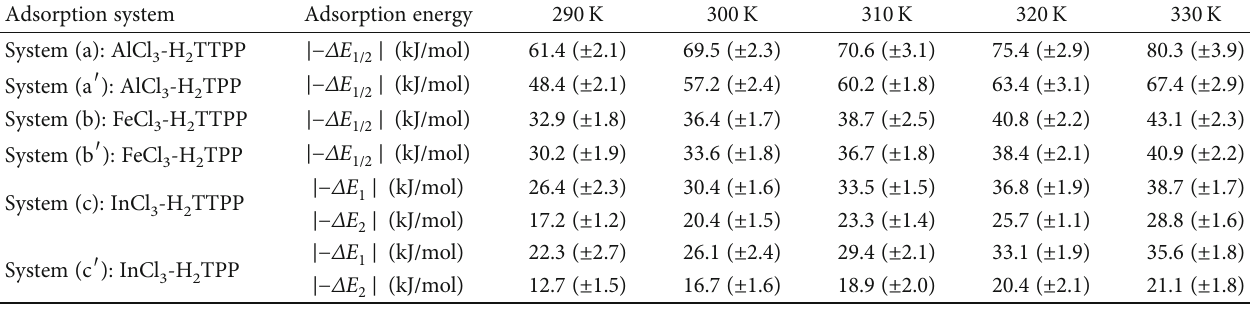
∣ for AlCl and FeCl adsorptions and ∣− Δ E 1 ∣ and ∣− Δ E 2 ∣ for InCl 1/2 3 3